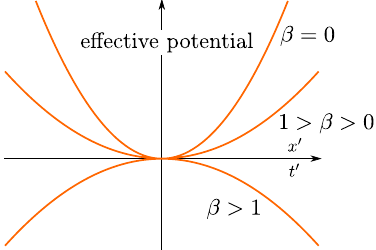
FIG. 2. Effective potential entering the squared Hamiltonian for the wave functions (cid:5) 0 ð x 0 Þ of the subluminal case ( (cid:9) < 1 ) and (cid:3) (cid:5) 0 ð t 0 Þ of the superluminal case ( (cid:9) > 1 ). The transition from a confining to a deconfining potential leads to extended rather than bound states for superluminal